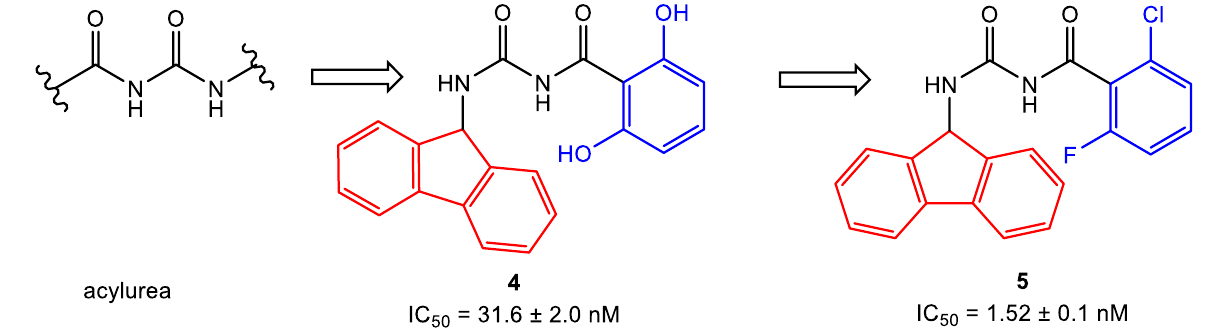
Figure 12. Discovery process of 4 and 5 .